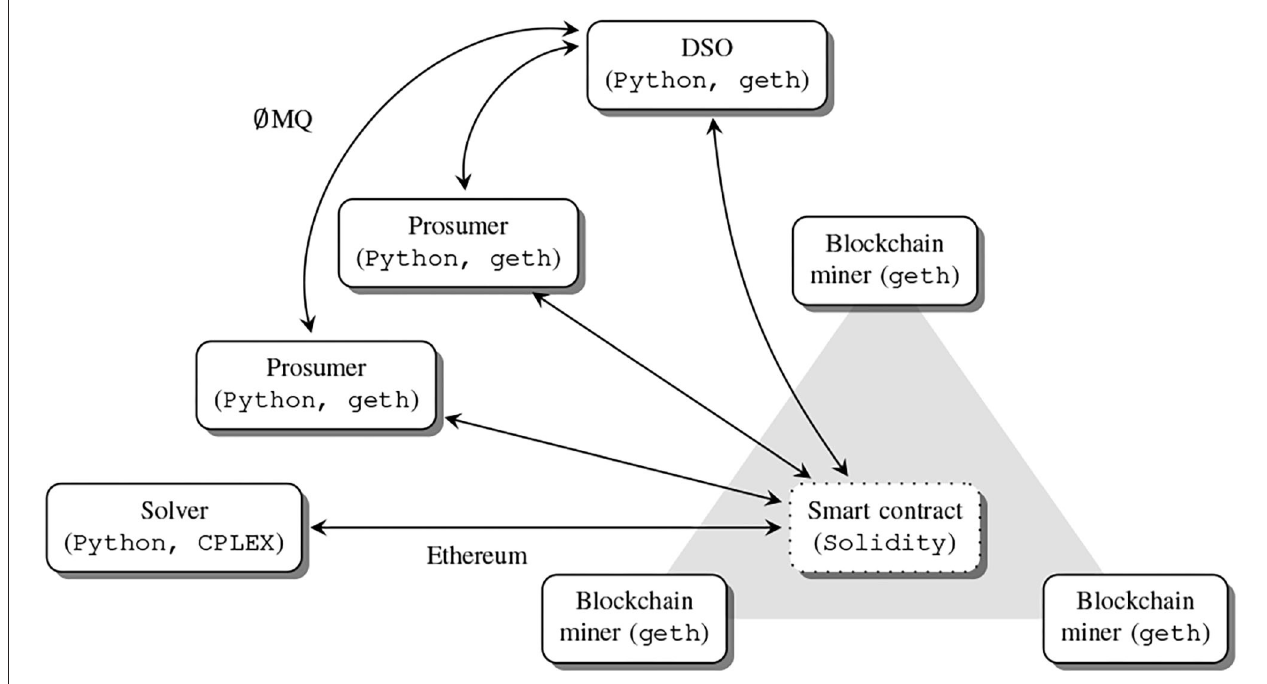
FIGURE 3 | Components of our blockchain-based energy trading